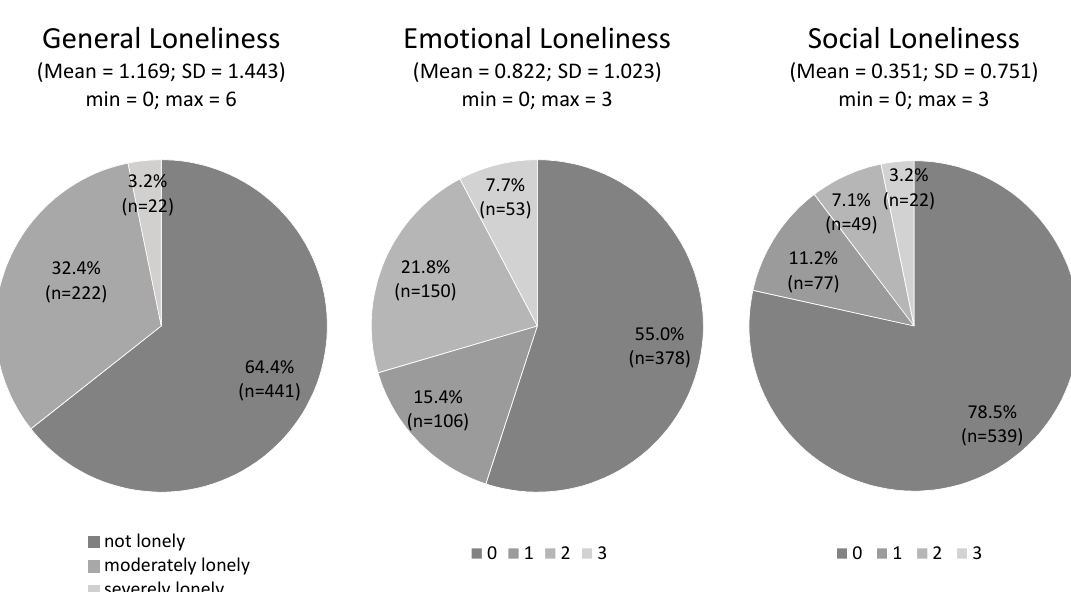
Figure 1. Loneliness in university students in Germany.